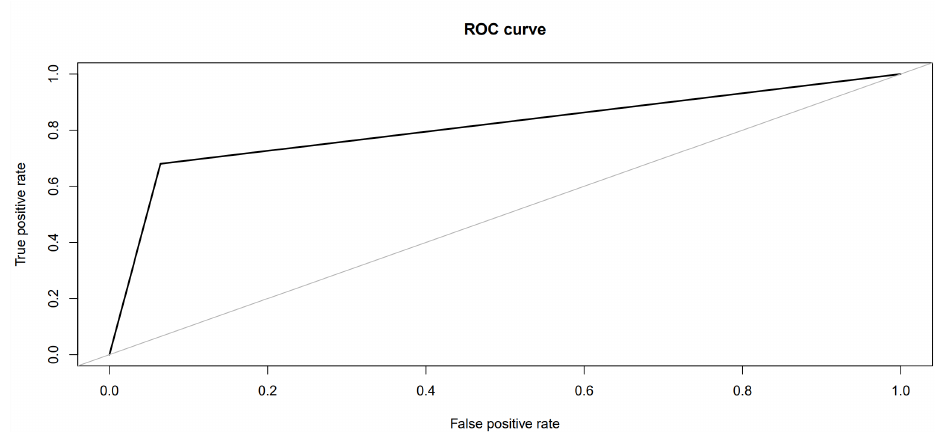
Figure 5. The ROC curve shows the performance of the prediction model on the control group. The confusion matrix was performed and reported in Table 1. Table 1. Confusion matrix of the test sample.